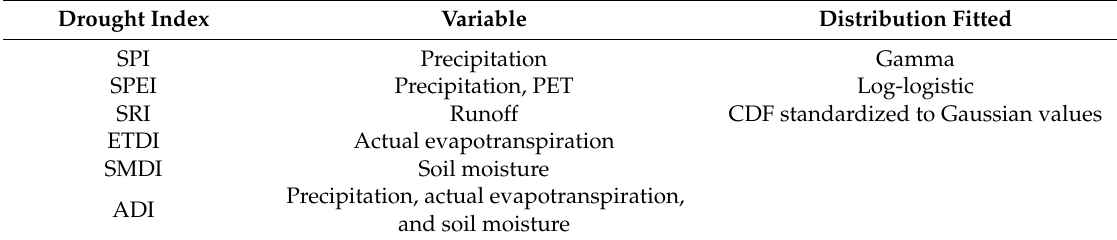
Table 5. Summary of the drought indices used in this